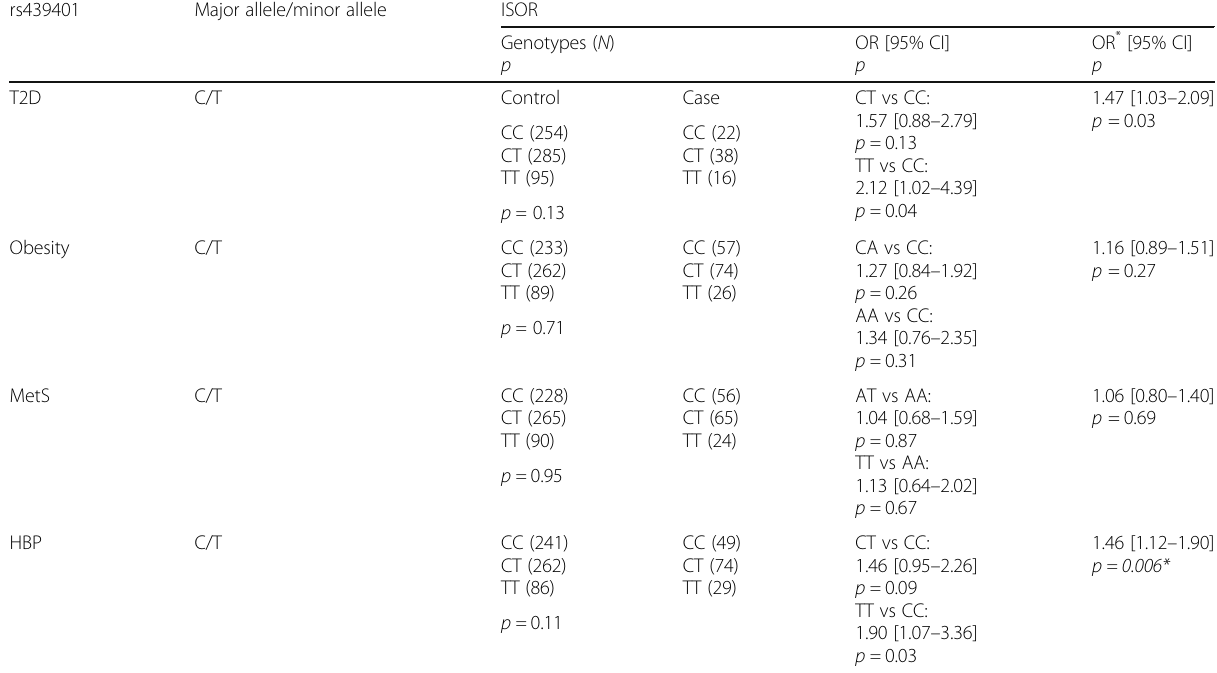
Table 5 APOE rs439401 polymorphism and cardiometabolic risk